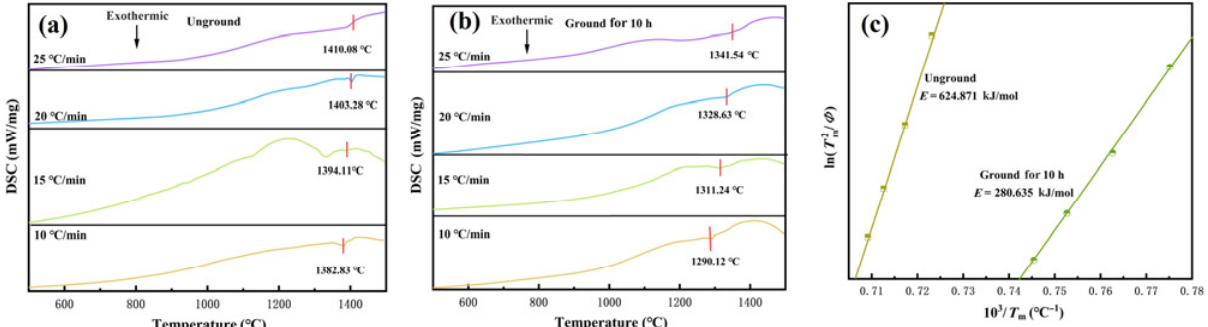
Fig. 5 DSC curves of raw material mixtures: (a) unground and heat-treated at different Φ ; (b) ground for 10 h and heat-treated at different Φ ; and (c) plots